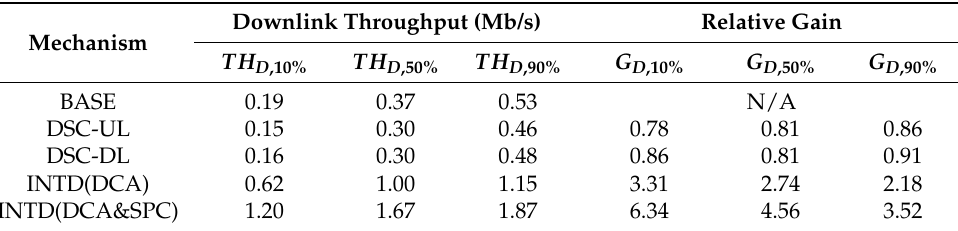
Table 2. Downlink throughput and its relative gain over the BASE mechanism under random network